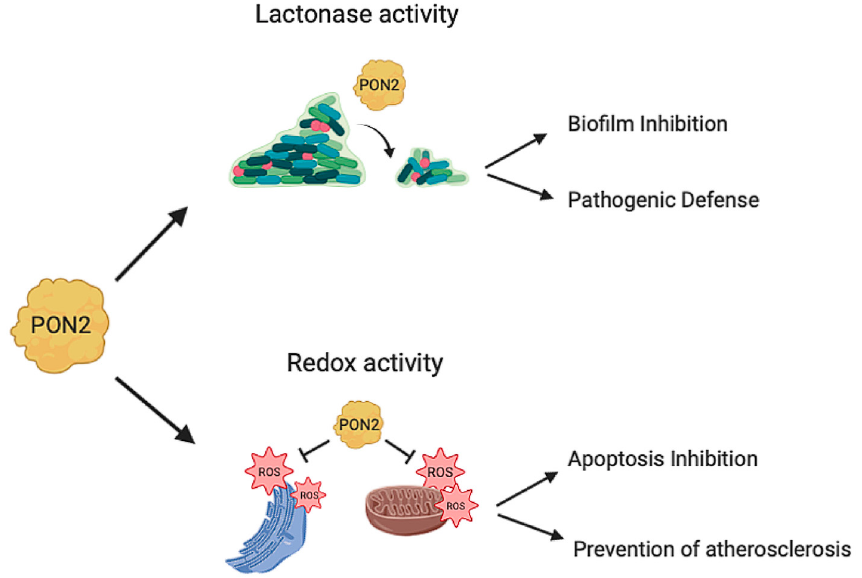
Figure 3. PON2 activities. PON2 with its lactonase activity is able to hydrolyze the quorum sensing signaling molecules used by bacteria during infection. This catalytic activity results in biofilm inhibition and defense from pathogenic infections. PON2 also has antioxidant activity reducing oxidative stress in mitochondria and in the endoplasmatic reticulum with different mechanisms as described in this review (Section 4; Section 4.1; Section 4.2). The PON2 redox activity inhibits apoptosis and prevents the formation of atherosclerotic lesions.